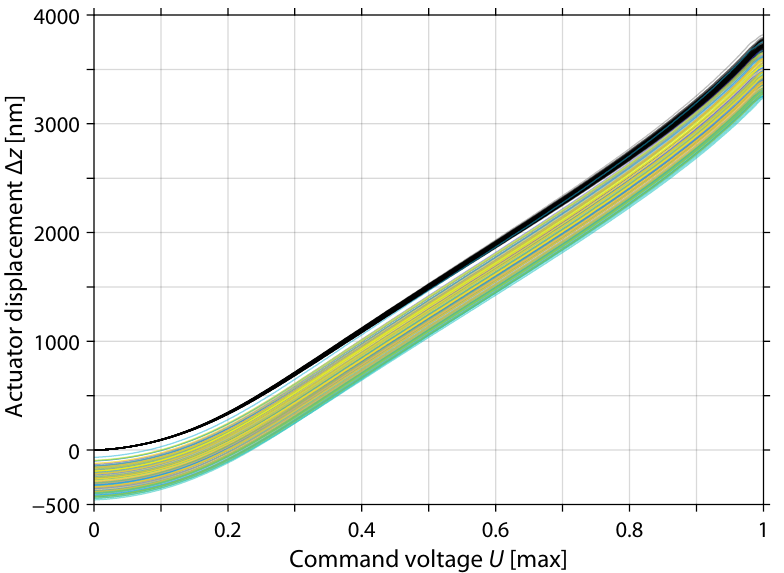
Figure 6. Actuator displacements versus command voltage. The colored curves show the absolute displacements extracted from the mirror topographies. The black curves show the displacements relative to zero